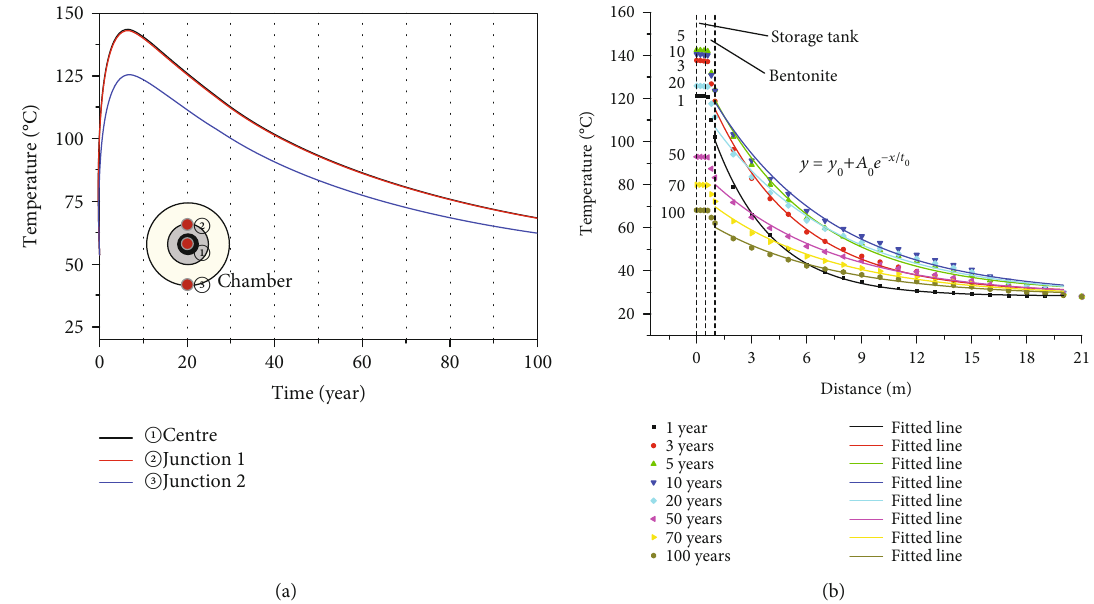
Figure 9: The temperature of the monitoring point changes with time: (a) Temperature change curve with time in roadway; (b) Temperature curve of surrounding rock with